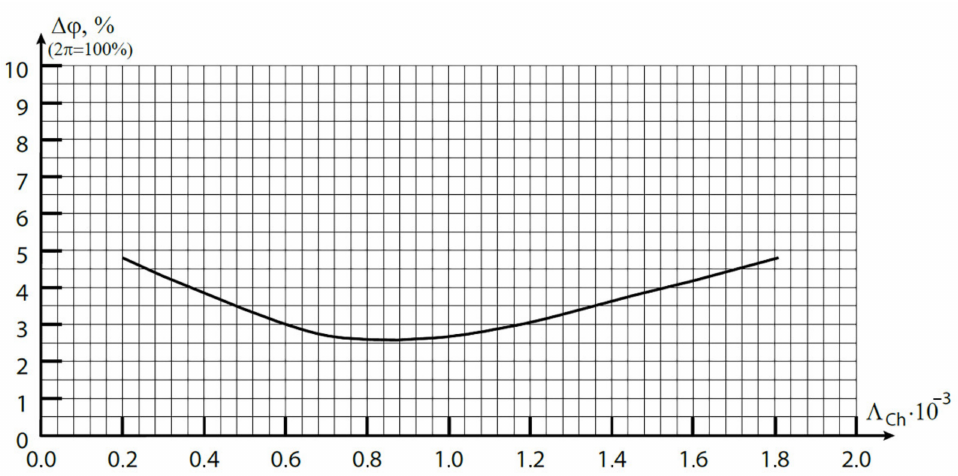
Figure 7. Dependence of the twist angle change from the chirp multiplier